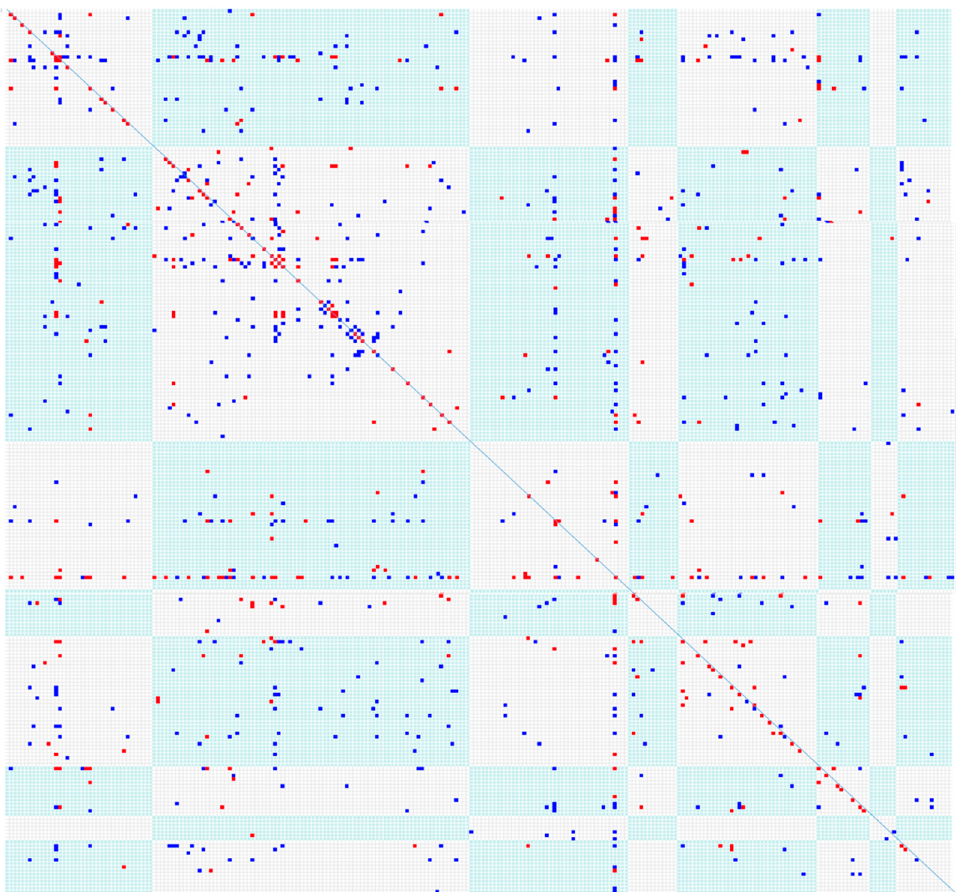
Figure 4 . Each row and column represent 240 Miscanthus genotypes, sourced from European collections. These were sorted into 8 phylogenetic groups distinguished by microsatellite DNA simple sequence repeats (SSRs) across the x-axis (seed bearing) and y -axis (pollen donor) by the background of alternating light blue and white. Each colored dot represents a cross or a selfing attempt: red for attempted but unsuccessful, blue for successful i.e., the cross produced progeny. Pollination control was achieved by bagging two panicles, one from each parent in pollen proof bags. The diagonal 1:1 line are self-pollinations made by bagging single panicles.